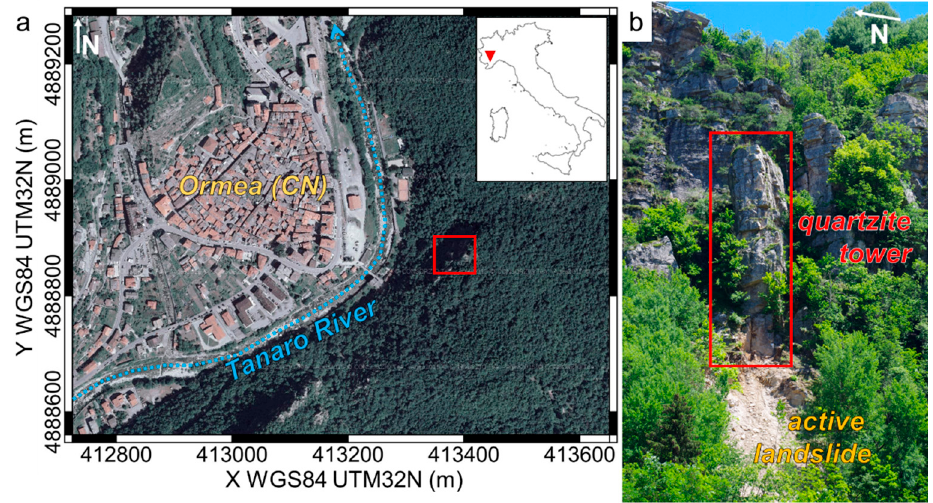
Figure 1. ( a ) Geographical location of the study site (Ormea, CN, NW Italy). The quartzite tower location is highlighted by the red rectangle. ( b ) Frontal view of the quartzite tower and active landslide at the base.